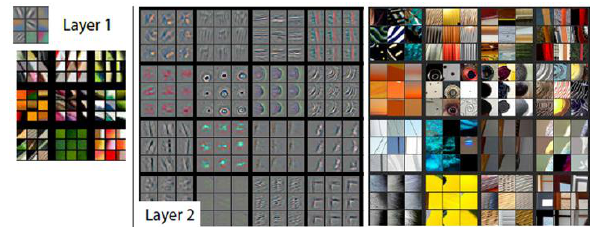
Figure 1. Features extracted by deep learning method